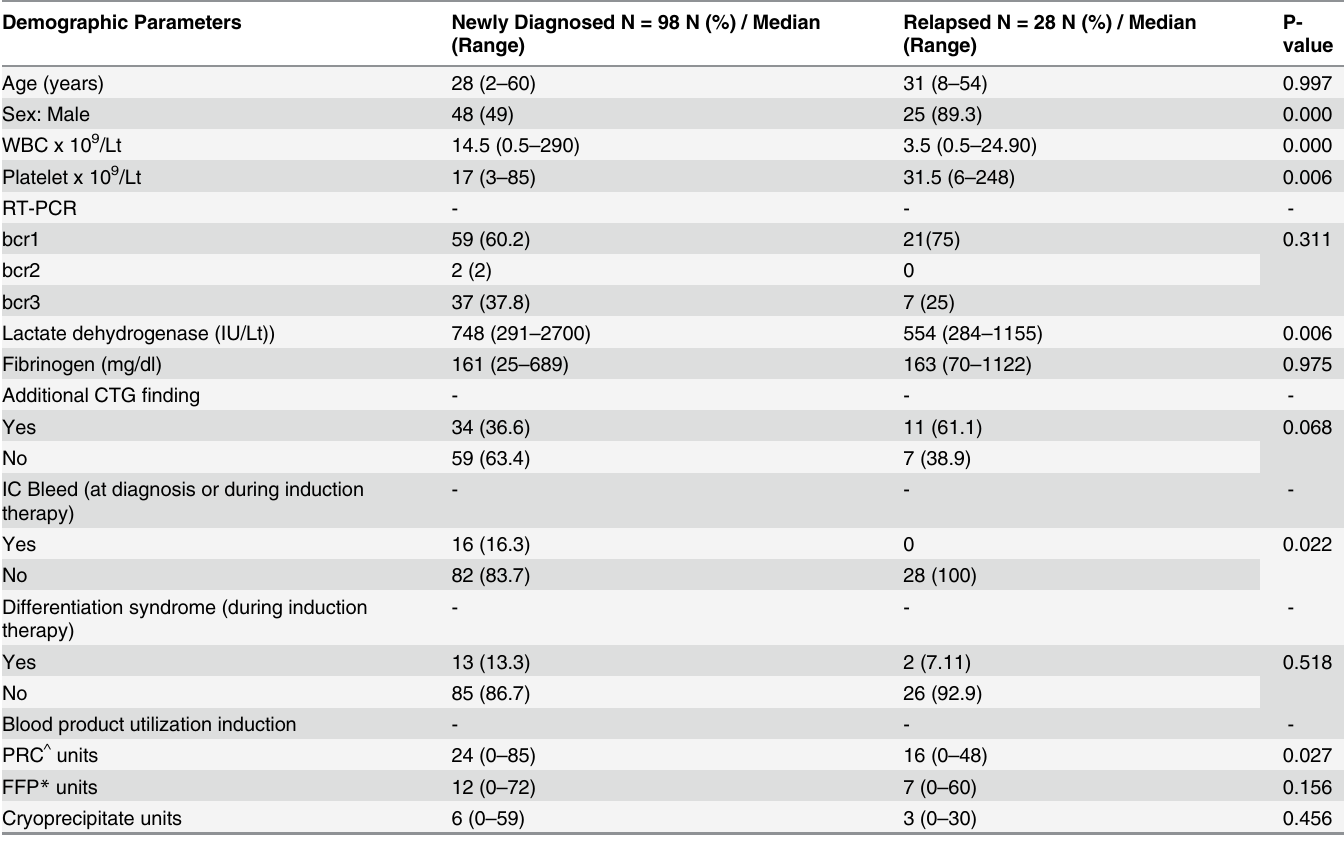
Table 1. Comparison of the clinical and demographic data of the newly diagnosed patients Vs. relapsed acute promyelocytic leukemia patients. Demographic